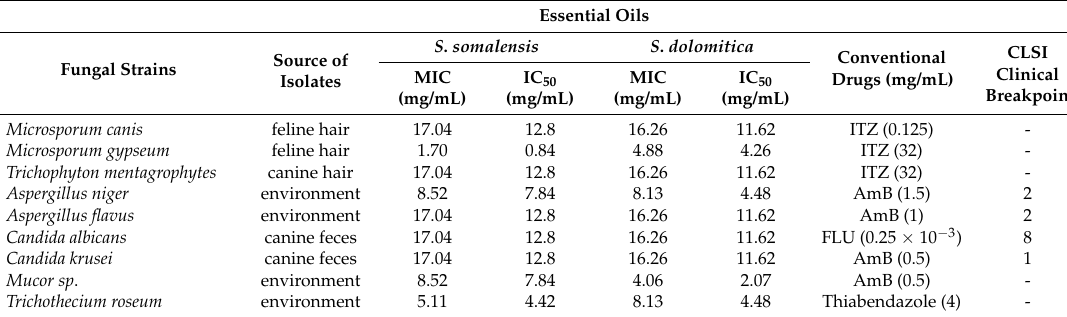
Table 3. Results of microdilution assay testing S . somalensis and S . dolomitica EOs and conventional antimycotic drugs against fungal strains from different